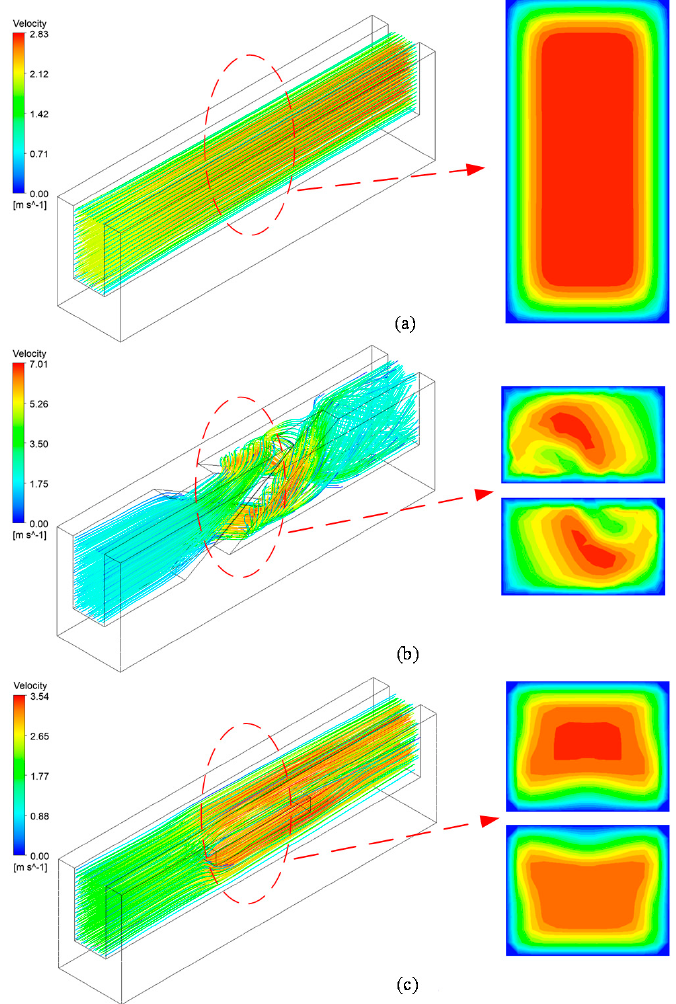
Figure 9. The streamline and velocity contours. ( a ) MC-R; ( b ) MC-CR; ( c ) MC-HR. Table 3. Detailed information about the aspect ratio of